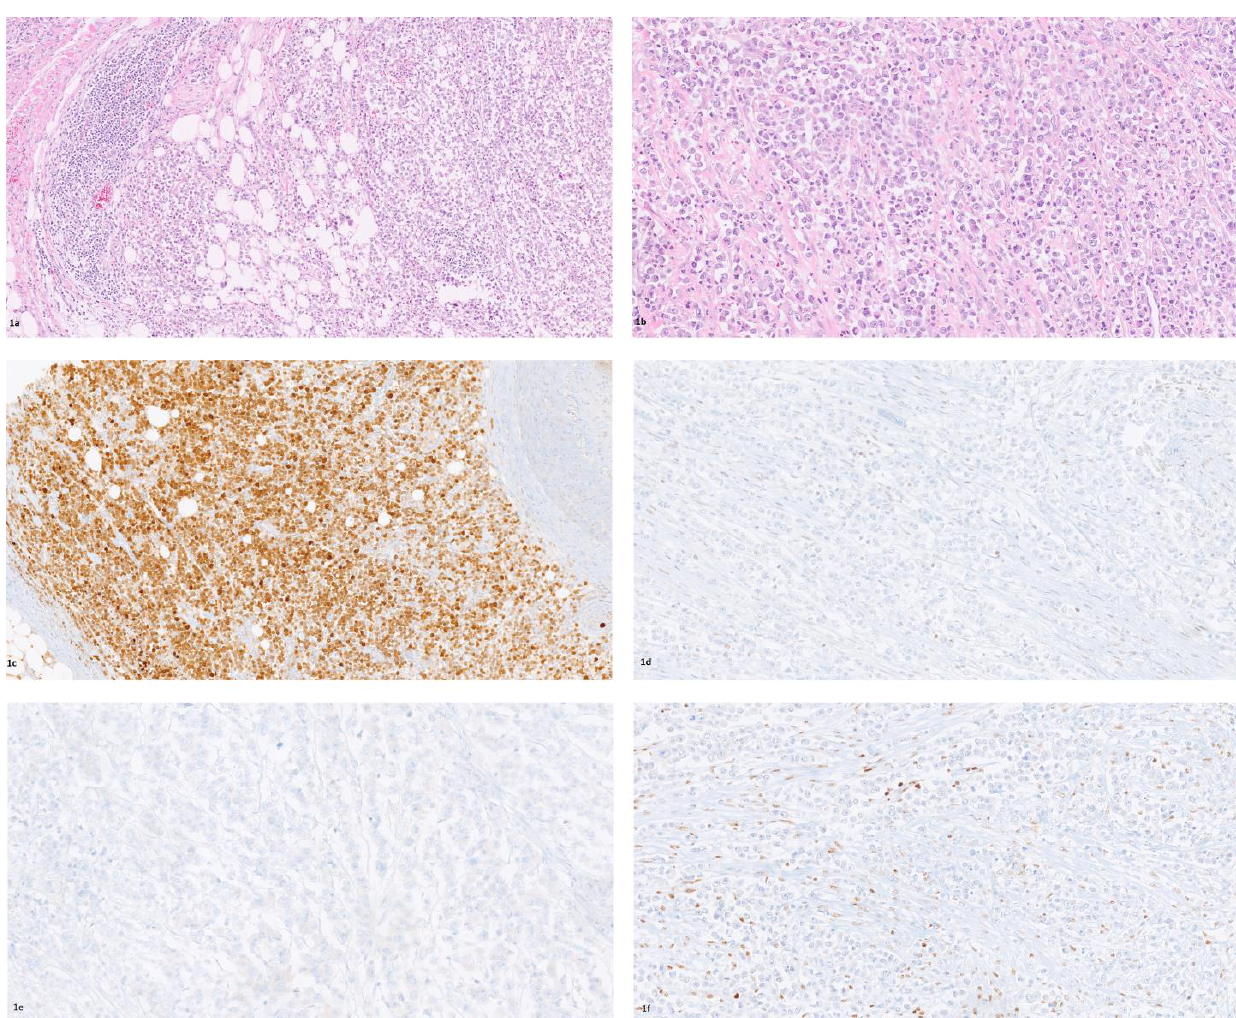
Figure 1. Neoplastic cells with abundant eosinophil cytoplasm and prominent nucleoli with intense intra- and peri-tumoral lymphocytic infiltration (( a ) H&E 10×; ( b ) H&E 20×); diffuse and strong calretinin expression in tumor cells (( c ) 10×); MLH1 loss (( d ) 20×), CDX2 negativity (( e ) 20×), and ARID1A loss (( f ) 20×) in tumor cells.